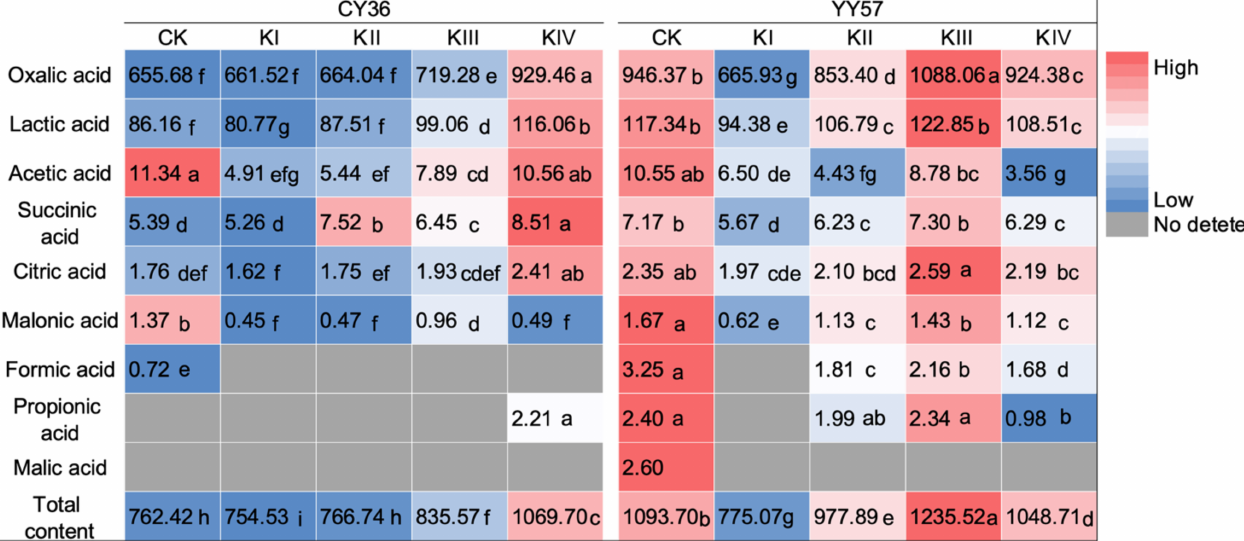
Figure 2. Effects of K supply level on the organic acids in root exudates of two rapeseed cultivars. KI, KII, KIII, and KIV indicate K supply level (K 2 SO 4 ) 0, 0.1, 1 and 10 mM under drought stress with 15% PEG, respectively, and CK indicate the control (without 15% PEG) 0.1 mM K 2 SO 4 . The numbers indicate the average content of organic acids ( n = 4). Different small letters mean significant differences in Duncan multiple range tests among different treatments at 5% level ( p <